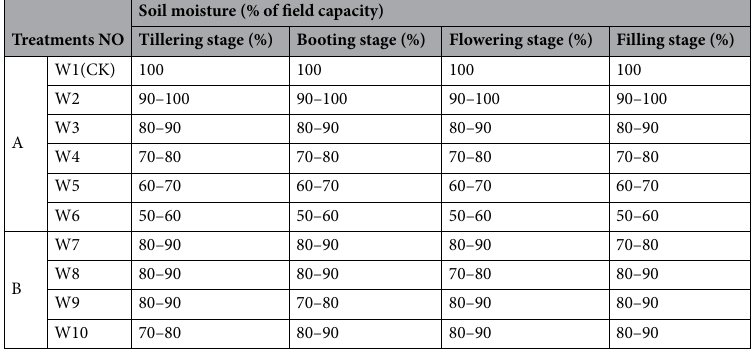
Table 2. Design scheme. The actual soil moisture content of the field was determined as a percentage of field capacity(θ), reflecting the degree of soil water deficit. In group A, WI:100% of field capacity; W2:90–100% of field capacity; W3:80–90% of field capacity; W4:70–80% of field capacity; W5:60–70% of field capacity; and W6:50–60% of field capacity. In group B, soil moisture deficit conditions were applied at different growt stages. W7: a filling stage deficit (70–80% of field capacity); W8: a flowering stage deficit (70–80%); W9: a booting stage deficit (70–80%); and W10: a tillering stage deficit (70–80%). The relative soil water content during the